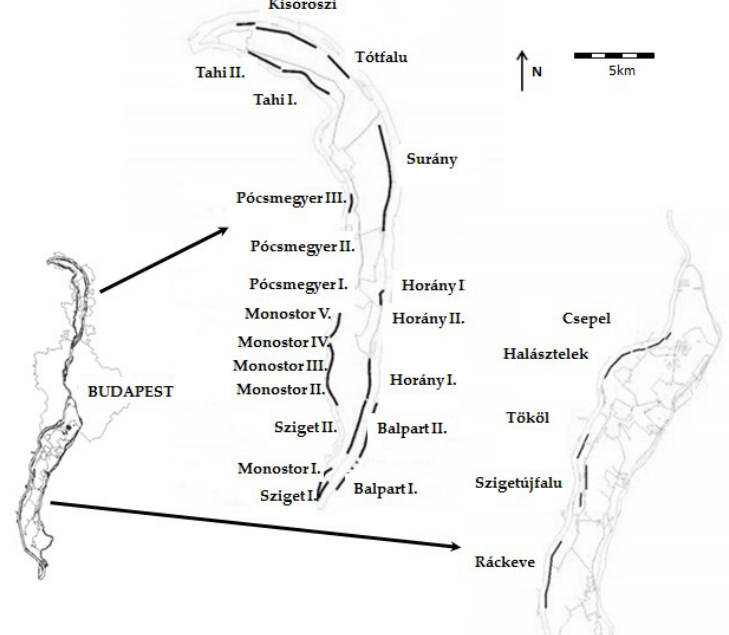
Figure 1. Location and names of well groups of the Budapest Waterworks at Szentendre Island (upstream the capital) and Csepel Island (downstream the capital).